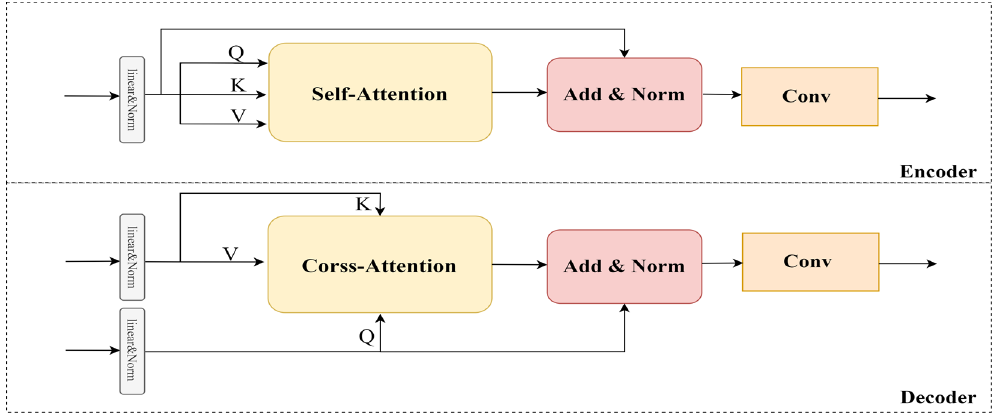
Figure 4. Speci fi c structure of the encoder and decoder. Figure 4. Specific structure of the encoder and